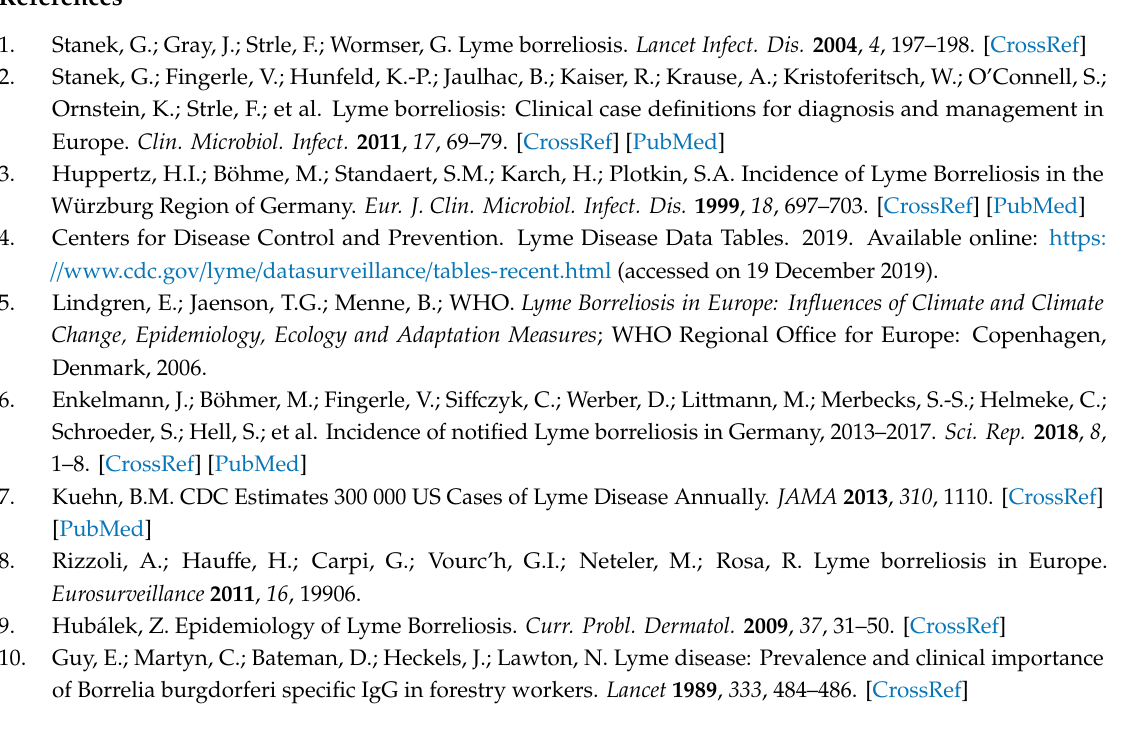
Figure S1: All samples of the population-based seroprevalence study in Germany, 1997–1999 were first tested with an ELISA to test for B. burgdorferi antibodies. In case of an equivocal or positive result, the B. burgdorferi antibodies were also assessed with an immunoblot. Figure S2: All samples of the population-based seroprevalence study in Germany, 2008–2011 were first tested with an ELISA to test for B. burgdorferi antibodies. In case of an equivocal or positive result, the B. burgdorferi antibodies were also assessed with an immunoblot, Table S1: Estimated seroprevalence and 95% confidence intervals (CI) by several variables for two cross sectional population-based serosurveys in Germany, BGS98 in 1997–1999 (n = 5510), and DEGS (n = 6957) in